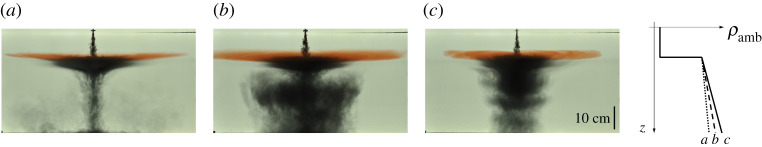
Illustration of a particle plume moving through a well-mixed zone underlain by a weakly stratified zone (experiments m-o, see table 2). (a) The weakly stratified case, in which the particles are drawn together on leaving the interfacial intrusion, and form a new particle plume; (b) The intermediate stratified case, in which the particles settle from the interfacial intrusion to form a nascent plume, which is then arrested by the stratification, forming a large intruding layer; (c) The more strongly stratified case in which the particles are unable to establish a particle plume prior to the convective downflow being arrested by the stratification. As a result, particles settle through the liquid forming a series of circulation patterns (cf. [3]). The photographs were captured at times (a) 45s, (b) 57s and (c) 59s after the beginning of each experiment. (Online version in colour.)